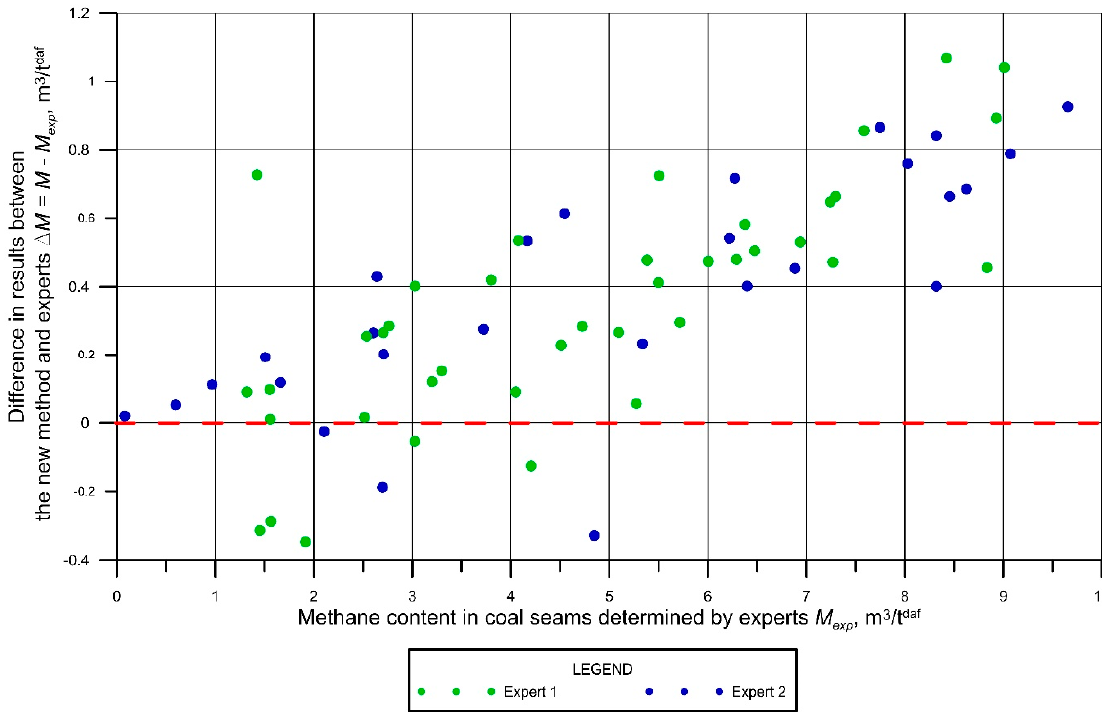
Figure 10. Comparison the results of the new method with the results of other experts/laboratories.